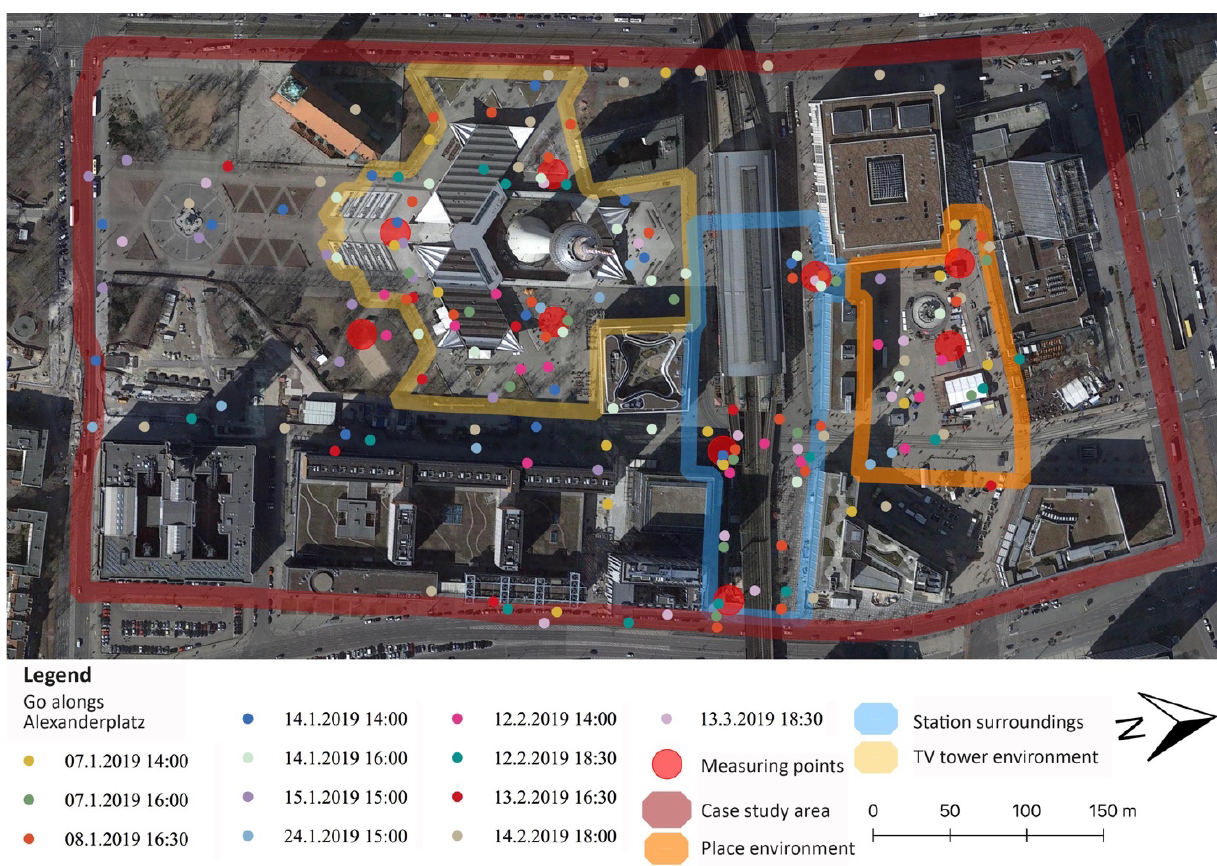
Figure 6. Map of security perception. Source: IRS. surveys. Whether and how one combines the methods